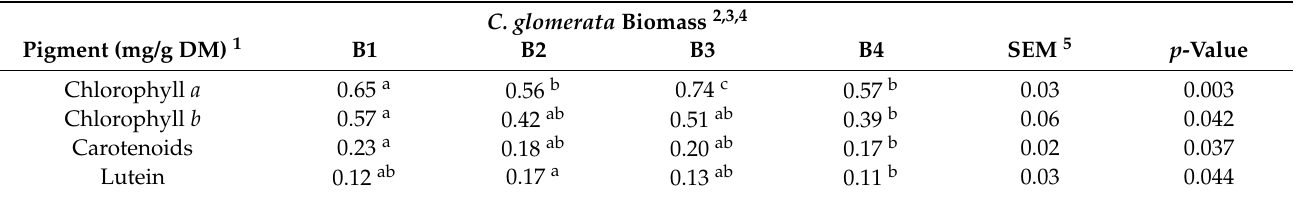
Table 4. Content of individual pigments (chlorophyll a and b , carotenoids, lutein) of C. glomerata biomass from various rivers in